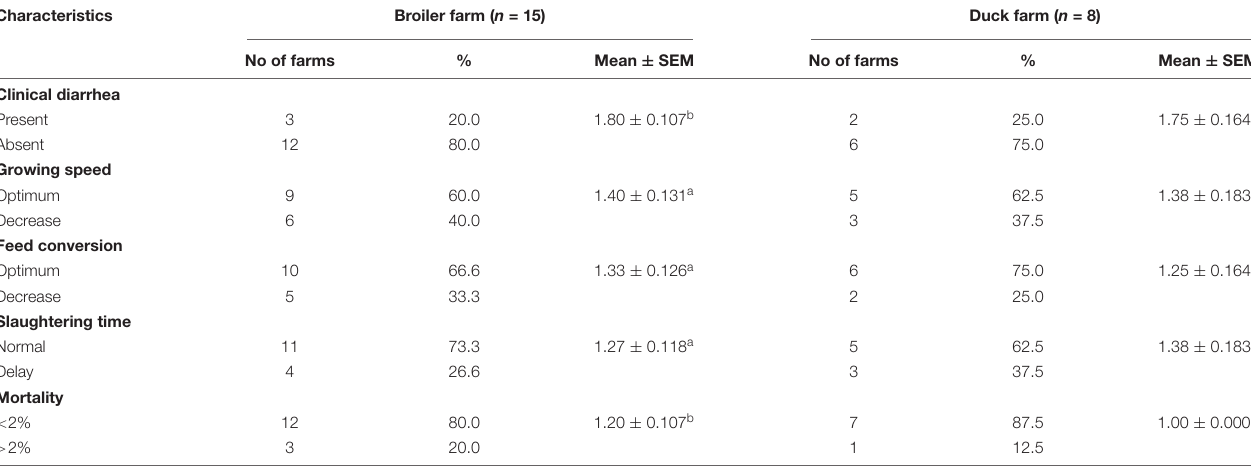
TABLE 6 | Association between Bacillus spp. contamination and meat bird’s production parameters. Characteristics